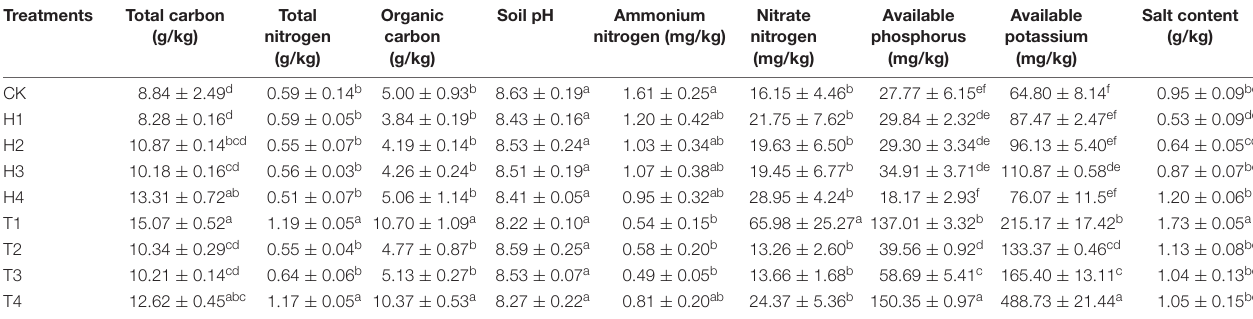
TABLE 1 | A summary of soil physicochemical properties in bulk soil of cut chrysanthemum.